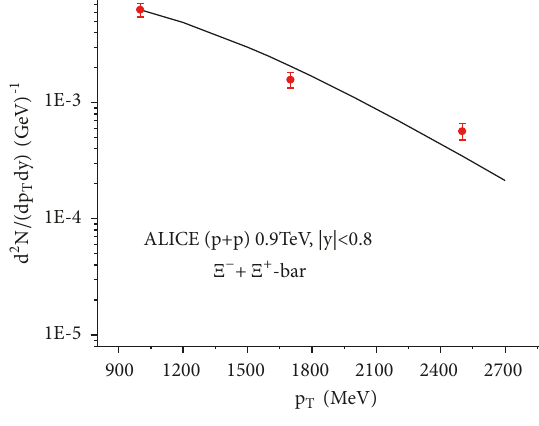
Figure 6: The 𝑝 𝑇 spectrum of (Ξ − + Ξ − ) .